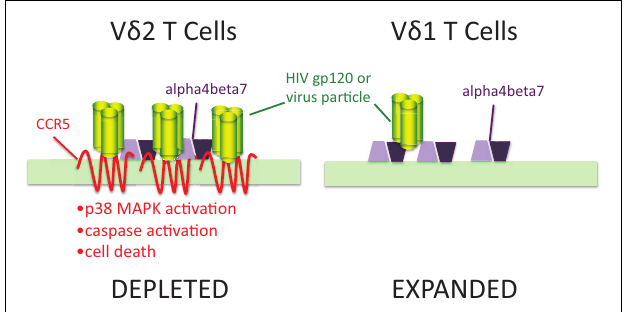
FIGURE 1 | Human immunodeficiency virus envelopes gp120 signaling through CCR5 is a mechanism for specific depletion ofV δ 2T cells .V δ 2T cells express high levels of two binding molecules for HIV gp120: chemokine receptor CCR5 and integrin α 4 β 7. InV δ 1 cells, gp120 (green trimers) bind to α 4 β 7 (purple polygons) but do not signal caspase activation or cause cell death. InV δ 2T cells, the presence of 7-transmembrane CCR5 (red) binds gp120 and signals through its associated p38 MAP kinase to increase caspase activity and cell death. Adapted from Ref. (62,